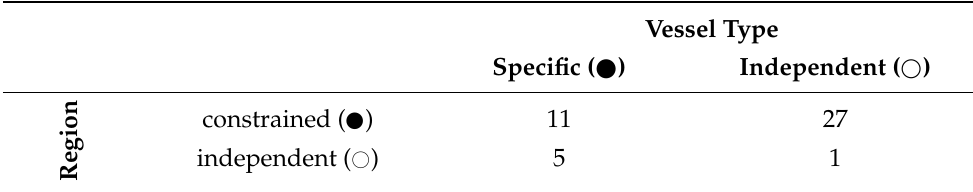
Table 4. Overall, the majority of publications (38 out of the total 44 from the review) consider a given constrained region, as show in the table below. Only a few (6) are region independent and generally applicable, i.e., worldwide. Furthermore, the minority (16) differentiate between vessel-specific types prior to training. Overall, most approaches (27) are vessel type independent and region